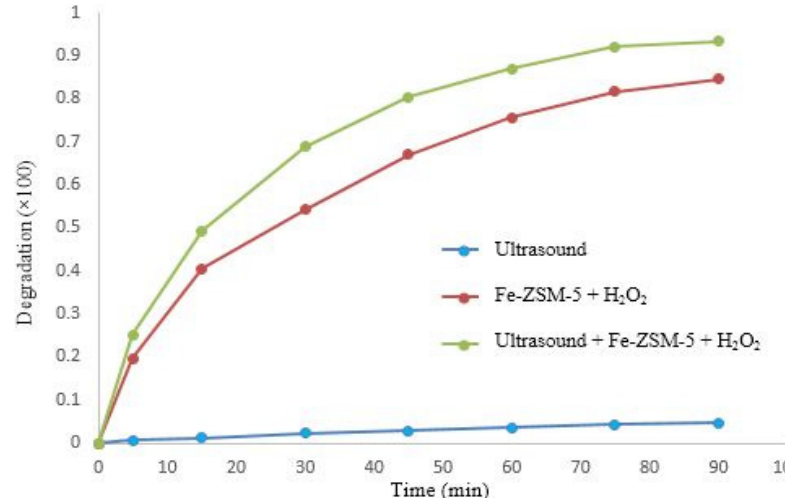
Fig. 14. Effect of Ultrasound Irradiation Power on Catalytic Degradation of Phenol